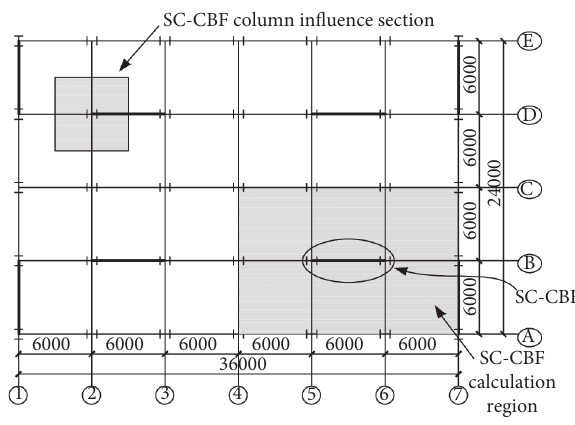
Figure 3: Floor plan of structure.